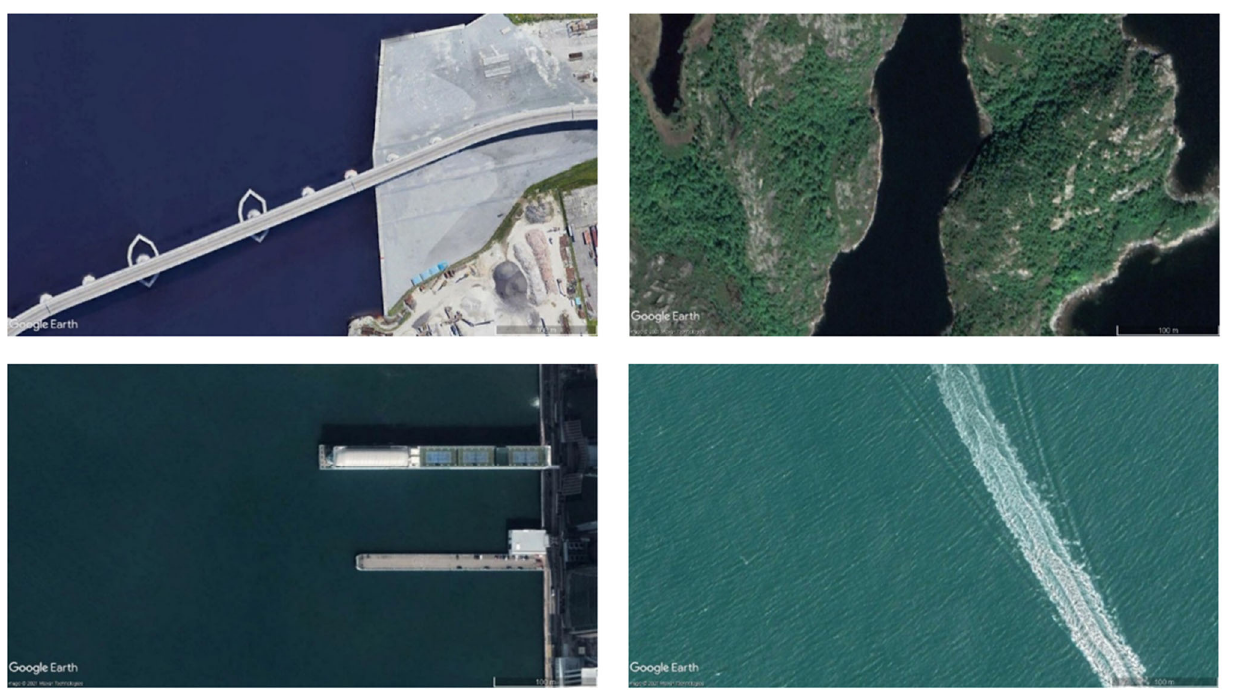
Figure A1. The example images from VHRShips without any ship.